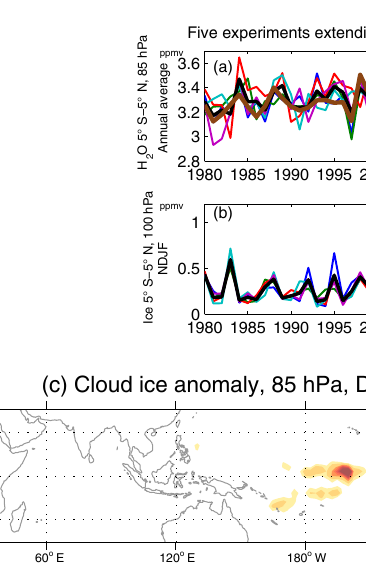
Figure 10. As in Fig. 2 but stratifying years based on 2m temperature from 50 to 150 ◦ E, 5 ◦ S–5 ◦ N.